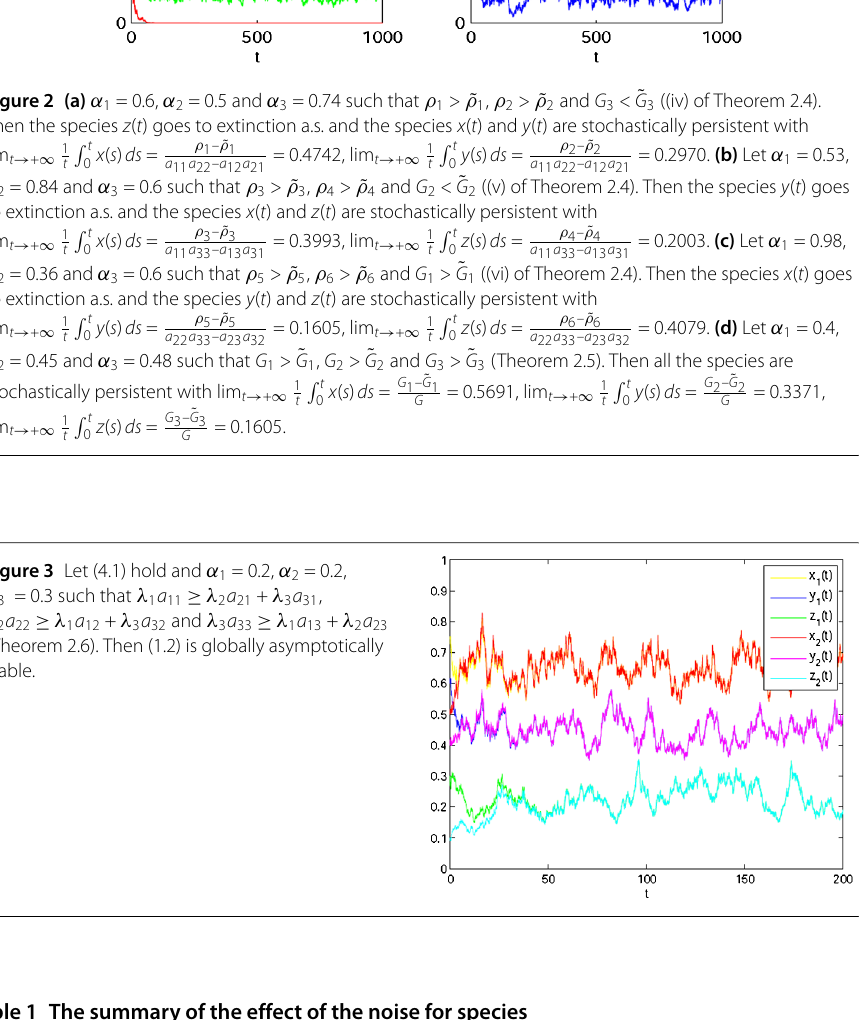
Table 1 The summary of the effect of the noise for species Noise Species x y z α 1 negative negative positive α 2 negative negative positive α 3 positive positive